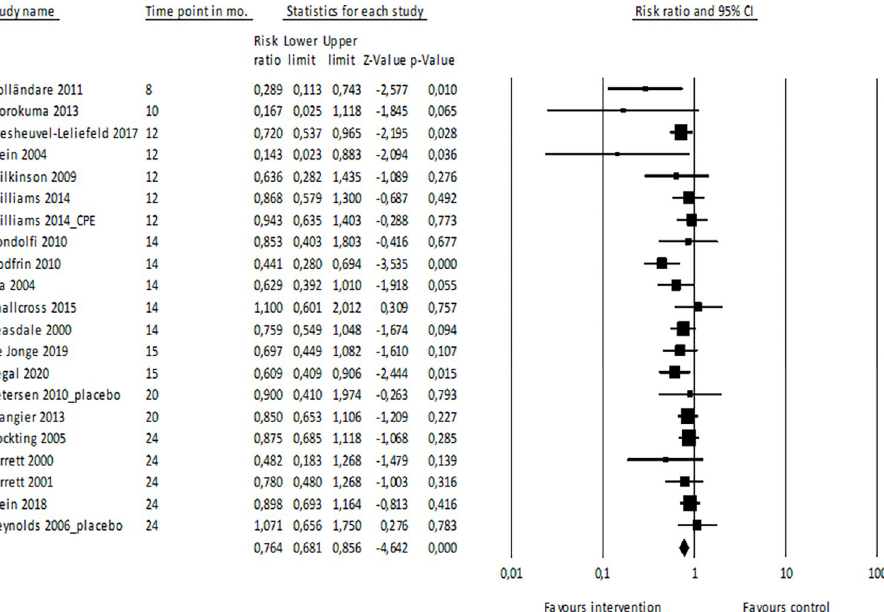
Fig 2. Meta-analysis of psychological interventions vs. TAU, up to and including 24 months. Note. CI = confidence interval; CPE = cognitive psychoeducation.